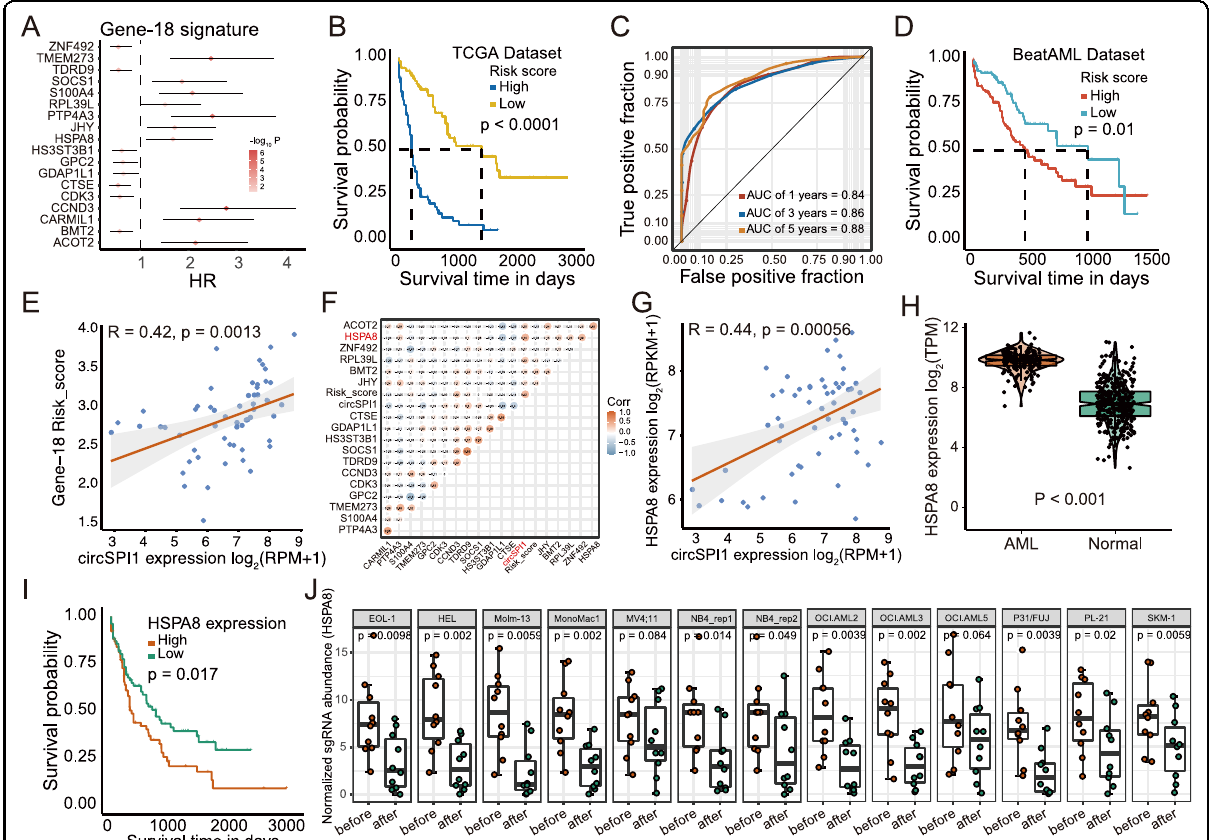
Fig. 6 CircSPI1-mediated gene network is associated with prognosis of AML patients. A The hazard ratios of the LASSO selected 18 genes. B Kaplan – Meier curve for the overall survival (OS) of AML patients classi fi ed by the median of Gene-18 risk score. C Receiver-operating characteristic (ROC) curve of the Gene-18 risk score. D Kaplan – Meier curve for the overall survival (OS) of AML patients classi fi ed by the Gene-18 risk score in the validated set. E The correlation of circSPI1-regulated 18-gene risk score and circSPI1 expression. F Correlation matrix of circSPI1 and circSPI1-regulated 18 genes. RNA quanti fi cation analysis was performed on the transcriptomic data of AML patients with enough sequencing depth that enabled the identi fi cation of both linear SPI1 and circSPI1. The Pearson method was used to assess the correlations among circSPI1 and circSPI1-regulated genes. G The correlation of HSPA8 and circSPI1 expression. H Expression levels of HSPA8 were analyzed in AML patients and normal subjects. I Kaplan – Meier curve for the overall survival (OS) of AML patients with high or low HSPA8 expression levels. J HSPA8 was essential for the survival of AML cells. Normalized read counts of sgRNA in AML cells transfected with the CRISPR-cas9/sgRNA library before and after population doublings are